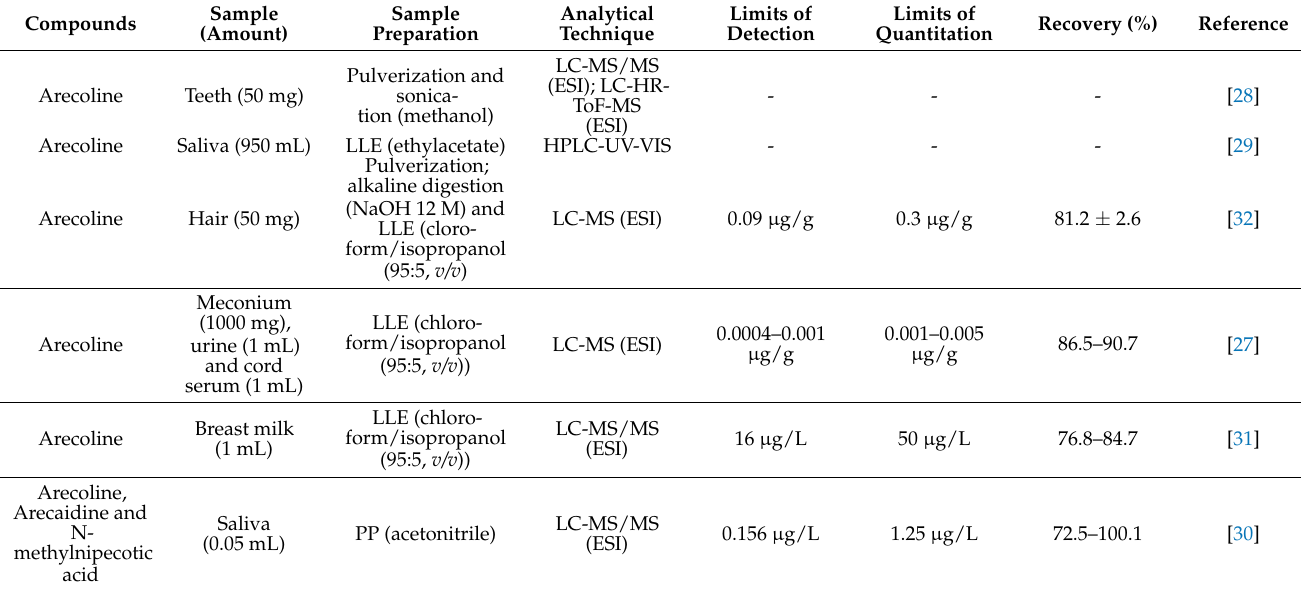
Table 1. Analytical methods for the determination of the main components of Areca catechu